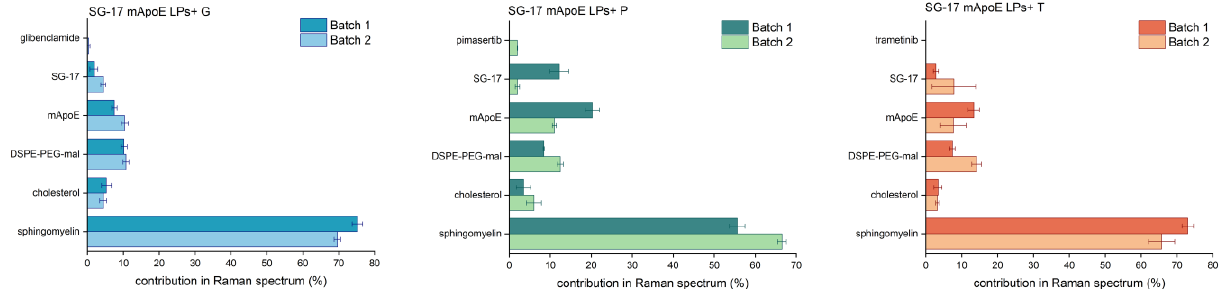
Figure 6. Comparison between different batches of the same formulation. The LP component contribution (%) in the final Raman spectrum was obtained from CLS fitting analysis; average and standard deviation of three spectra for each batch are reported.